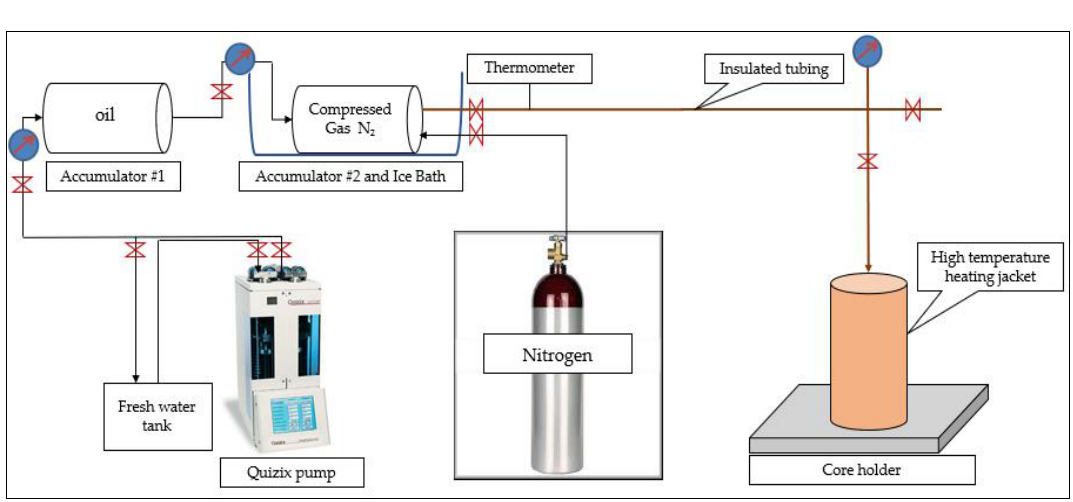
Figure 5. Schematic diagram of thermal shock technique setup.